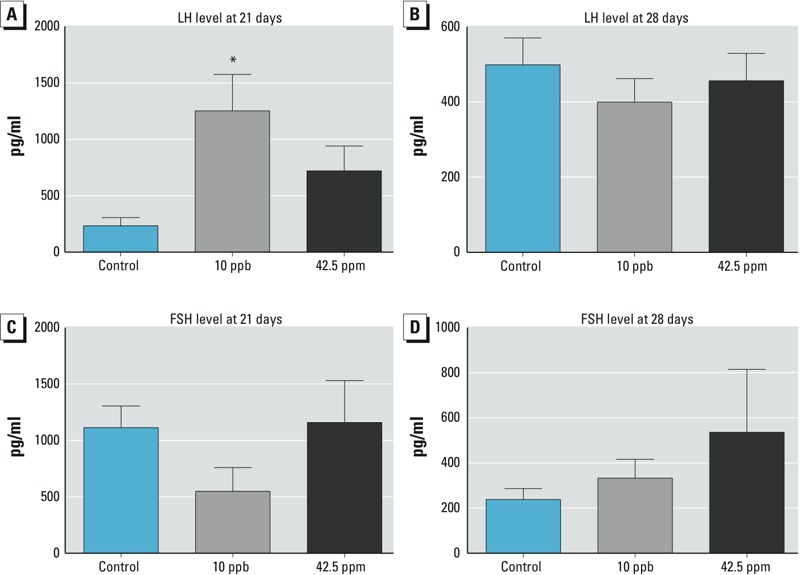
Effects of in utero arsenic exposure on levels of serum LH (A,B) and FSH (C,D) at 21 and 28 days of age (mean ± SE).
Abbreviations: LH, luteinizing hormone; FSH, follicle-stimulating hormone; *p < 0.05 compared with control group.